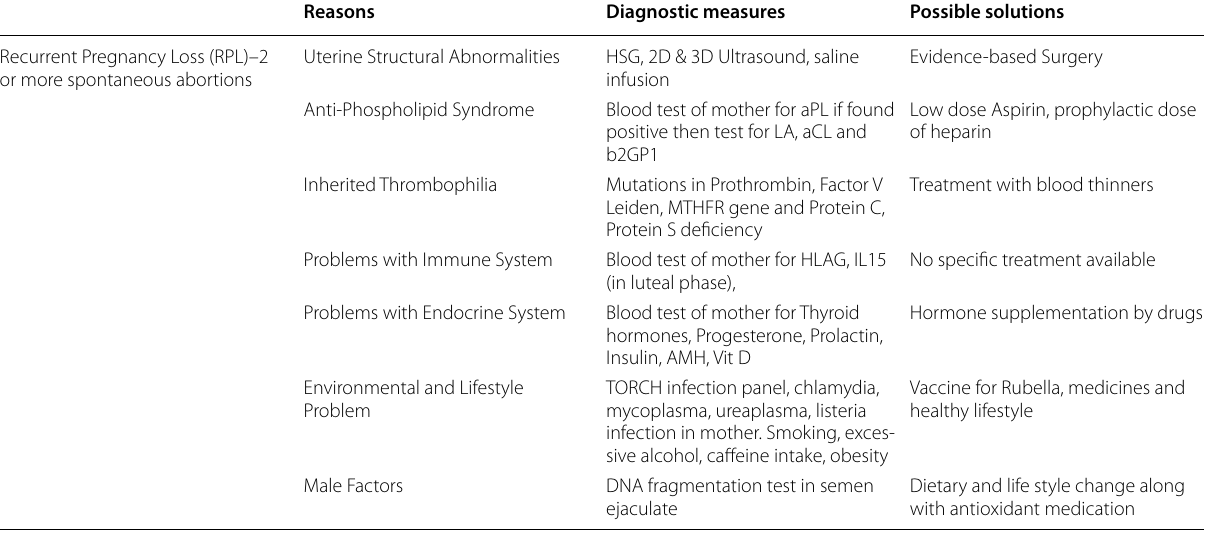
Table 2 The general causes of recurrent pregnancy loss and common remedial measures Reasons